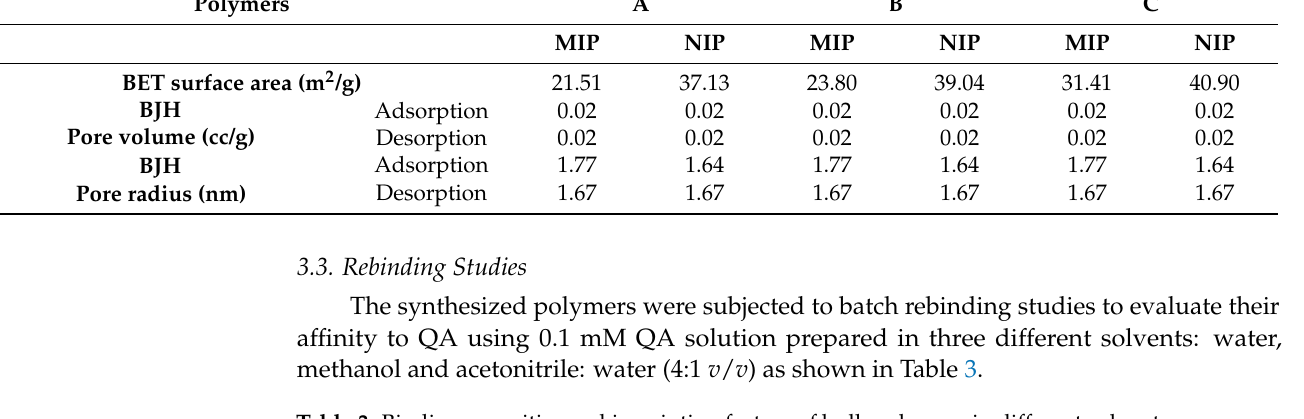
Table 3. Binding capacities and imprinting factors of bulk polymers in different